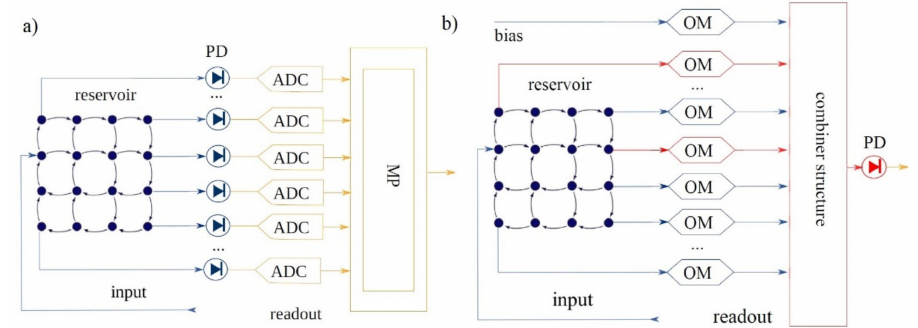
Figure 14. ( a ) The mixed way for training: the optical signal from every node of the reservoir (blue) is transferred through a photodetector (PD) to the electric space (yellow) and through an A/D